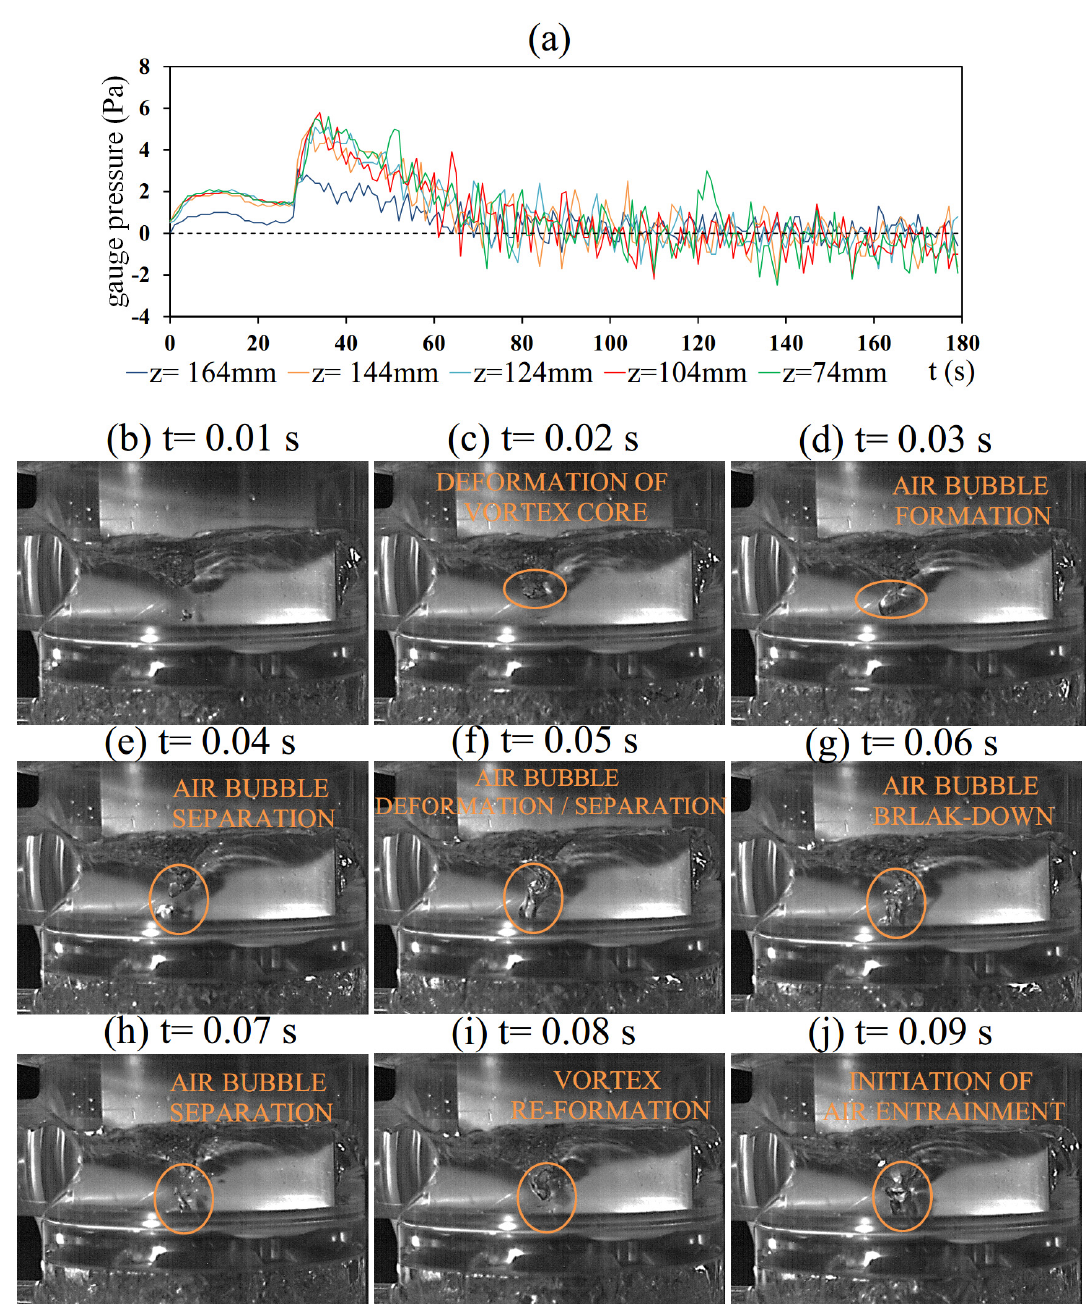
Figure 6. Temporal airflow pressure variations and corresponding flow snapshots demonstrating the process of air entrainment by entry